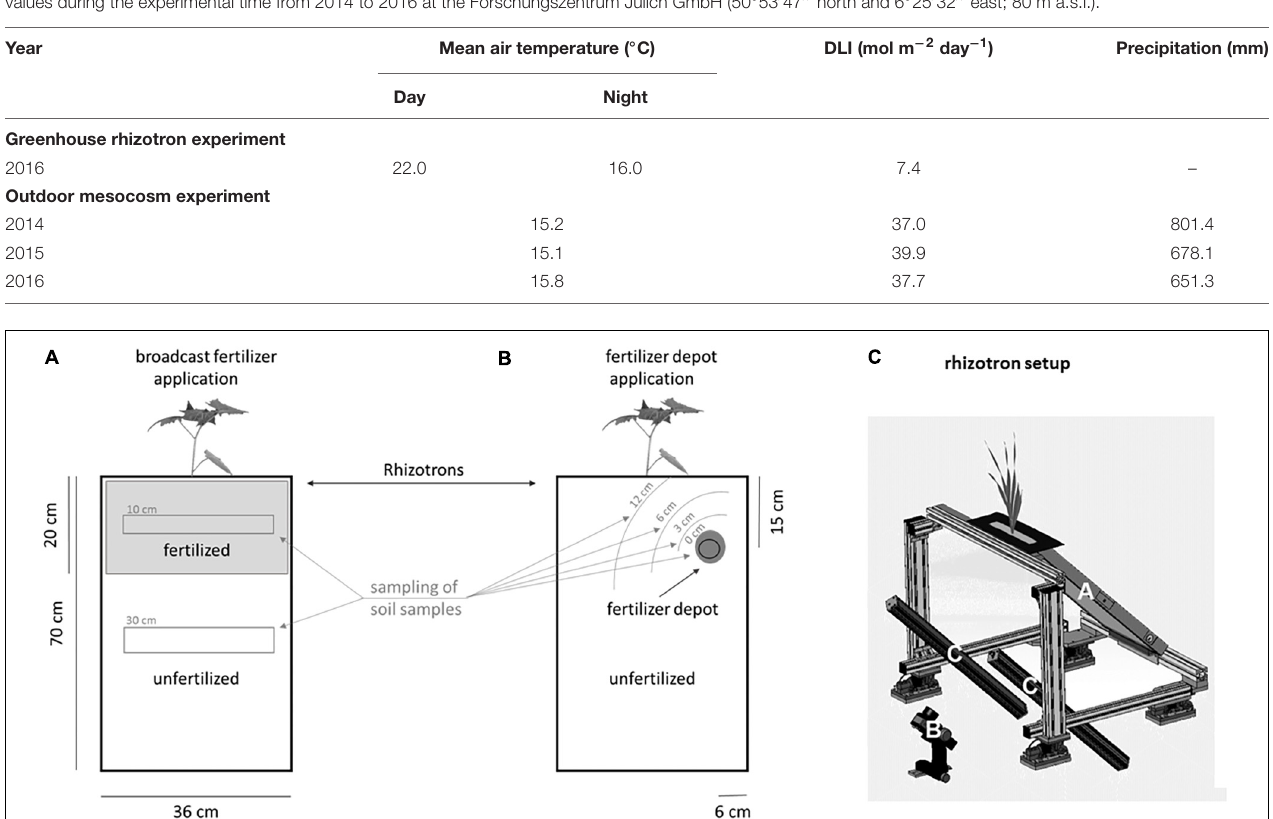
TABLE 1 | Climate data for the greenhouse rhizotron experiment and the outdoor mesocosm experiment: mean temperature, precipitation and daily light integral (DLI) values during the experimental time from 2014 to 2016 at the Forschungszentrum Jülich GmbH (50 ◦ 53 (cid:48) 47 (cid:48)(cid:48) north and 6 ◦ 25 (cid:48) 32 (cid:48)(cid:48) east; 80 m a.s.l.).